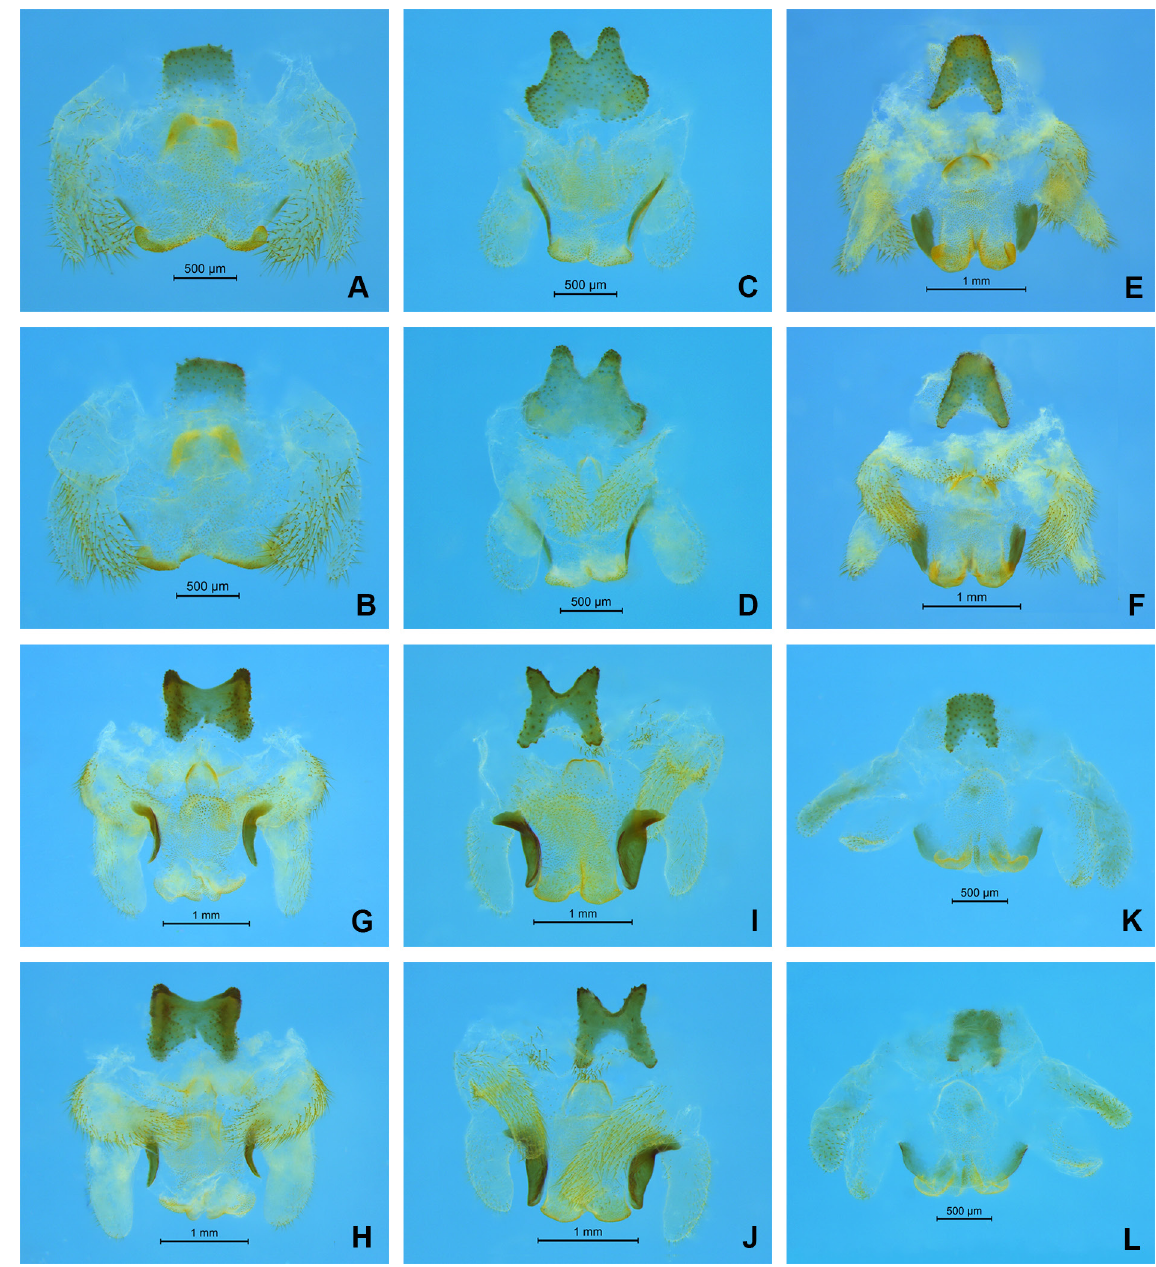
Fig. 8. Male genitalia. A , C , E , G , I , K . Dorsal view. B , D , F , H , J , L . Ventral view. A–B . Tachycines ( Gymnaeta ) quadratus sp. nov., holotype, ♂ (HBU). C–D . Tachycines ( Gymnaeta )